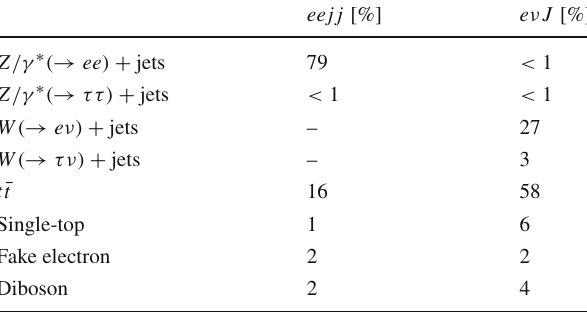
Table 3 Relative contributions of background processes to the total number of preselected background events. The event yields are nor- malized to the theoretical cross sections. Contributions included into the fake-electron background are denoted by “—”. The ’fake electron’ row includes all sources of events with misidentified electrons. These events are vetoed in the simulated event samples to prevent